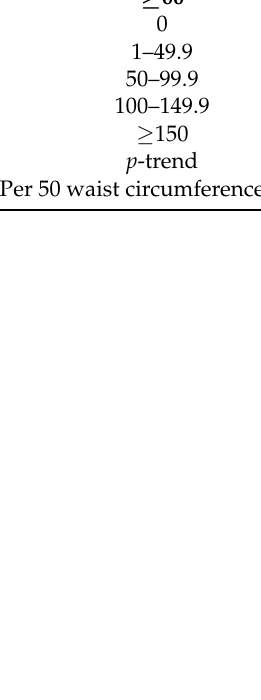
Table 4. ROC curve analysis